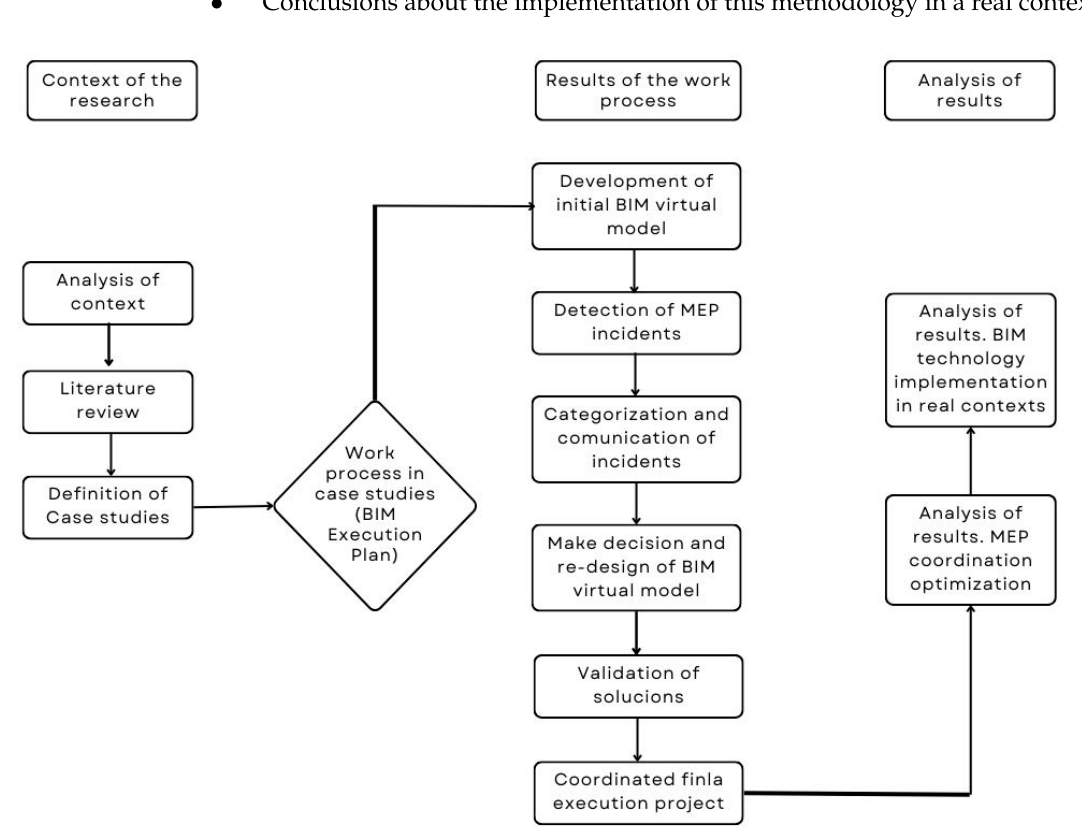
Figure 1. Flow chart of the research methodology.